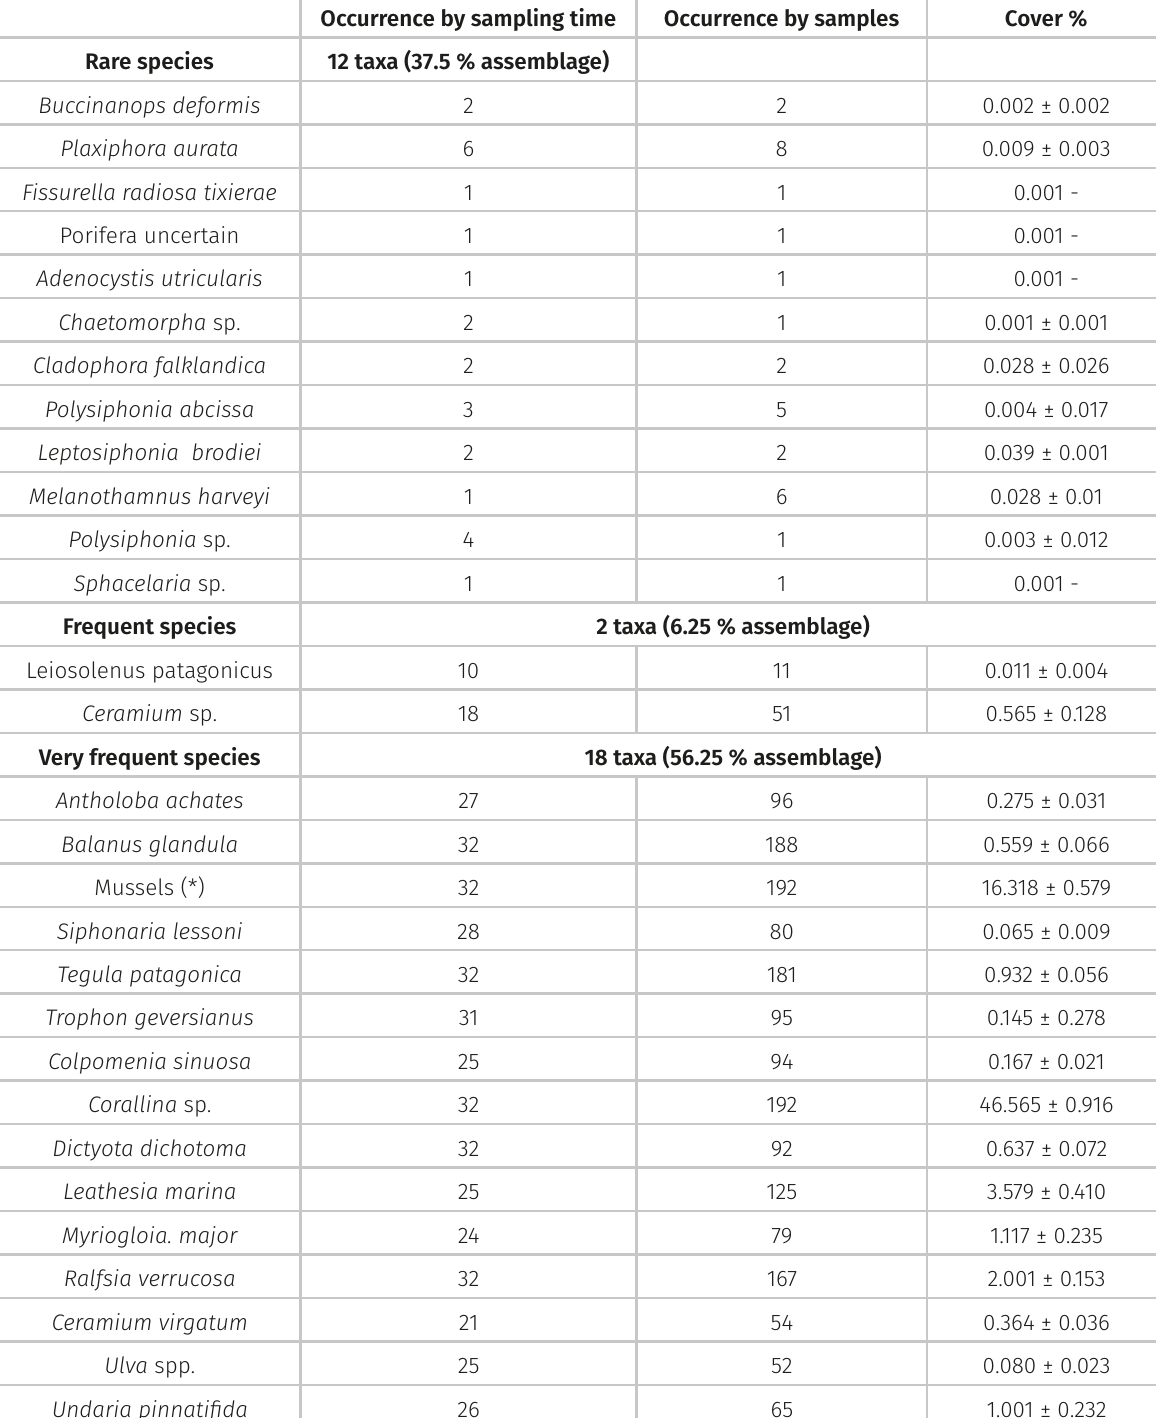
Table III. Occurrence expressed as the presence at any sampling time or number of samples of rare species (recorded 1-9 times), frequent species (recorded 10-18 times) and very frequent species (recorded 19-32 times). Biomass is cover/0.25 m2 ± standard error; single occurrence denoted by (-), no error is